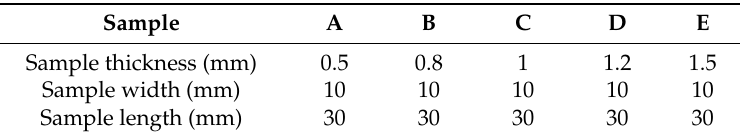
Table 2. The dimensions of different